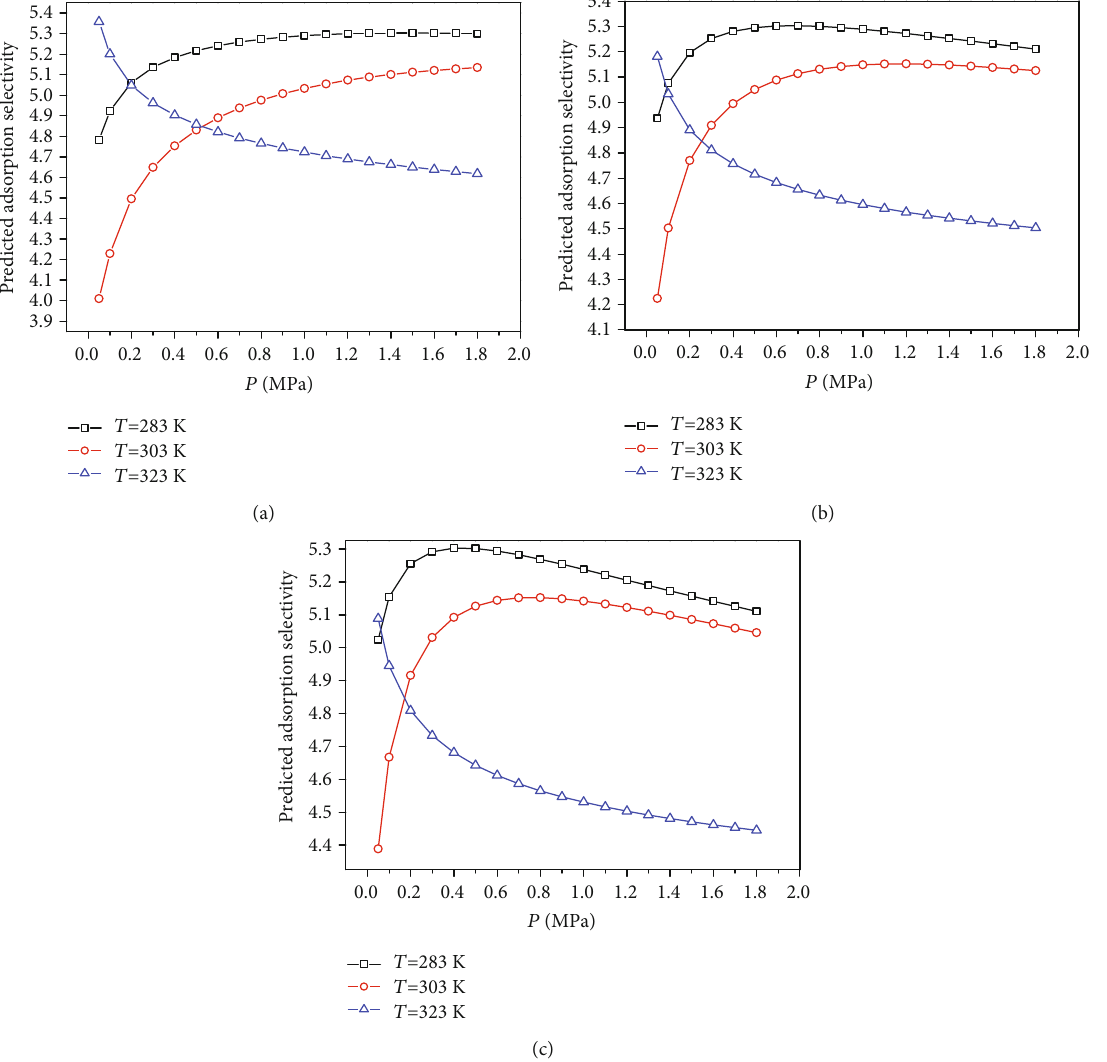
Figure 7: Comparison of predicted adsorption selectivity of CO mixture gases: (a) y CO